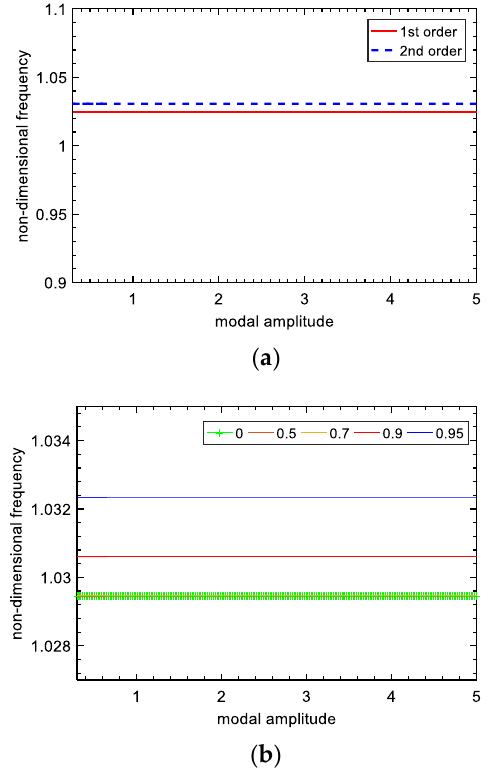
Figure 5. Frequency vs. modal amplitude: ( a ) frequencies of the lumped model; ( b ) frequency change in different γ net s.